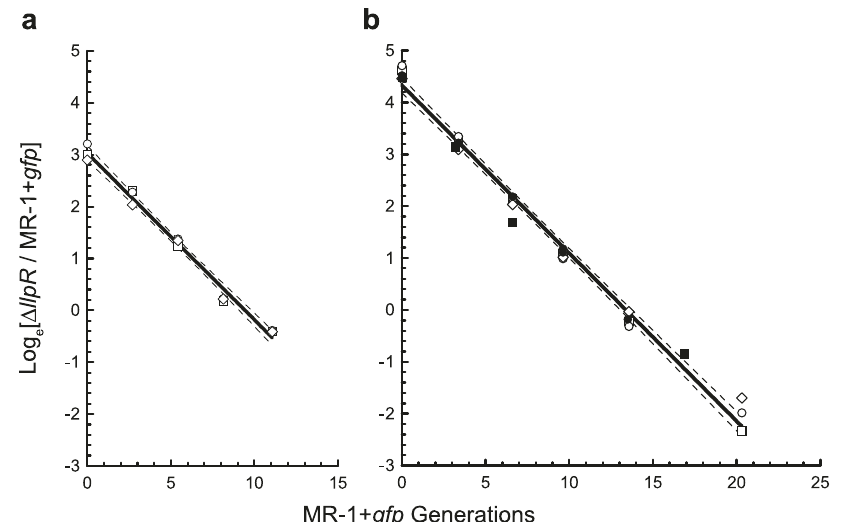
Fig. 2 Planktonic competition. Anaerobic competition for lactate with fumarate as the terminal electron acceptor. The slopes of the solid lines (selection coef fi cients per MR-1 + gfp generation estimated by linear regression) reveal strong selection against strain Δ llpR when placed in competition with strain MR-1 + gfp . a Three replicate competitions in planktonic batch growth with an overall selection coef fi cient of − 0.321 ± 0.010 gen − 1 (relative growth rate w = 0.536 ± 0.014). b Five replicate competitions across two experiments in bioreactors with electrodes unpoised; overall selection coef fi cient of − 0.324± 0.007 gen − 1 (relative growth rate w = 0.533 ± 0.010). Different symbols (white or black diamonds, circles, and squares) represent replicate competitions. Dashed lines indicate 95% con fi dence bands derived from linear